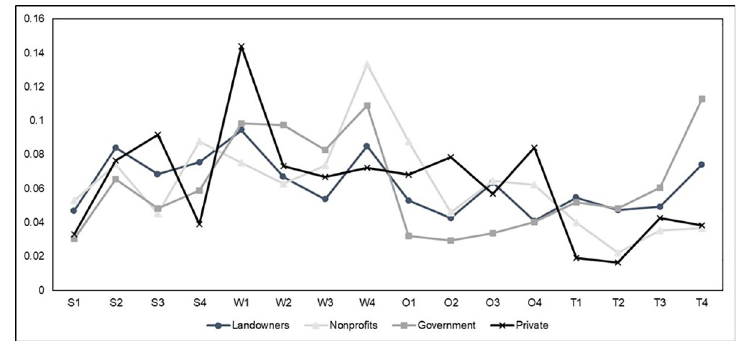
Fig 8. Overall perceptions of SWOT factors by stakeholder group. S1: enhanced environmental services, S2: income opportunities, S3: participation in existing networks, S4: connection to land, W1: limited knowledge of forest management, W2: lack of women-centric outreach programs, W3: limited women forest professionals, W4: absence of initial contact, O1: peer-to-peer educational opportunities, O2: community development, O3: access to new markets, O4: enhanced job opportunities for women, T1: investment risks, T2: lack of representations, T3: absenteeism, T4: limited interest from future